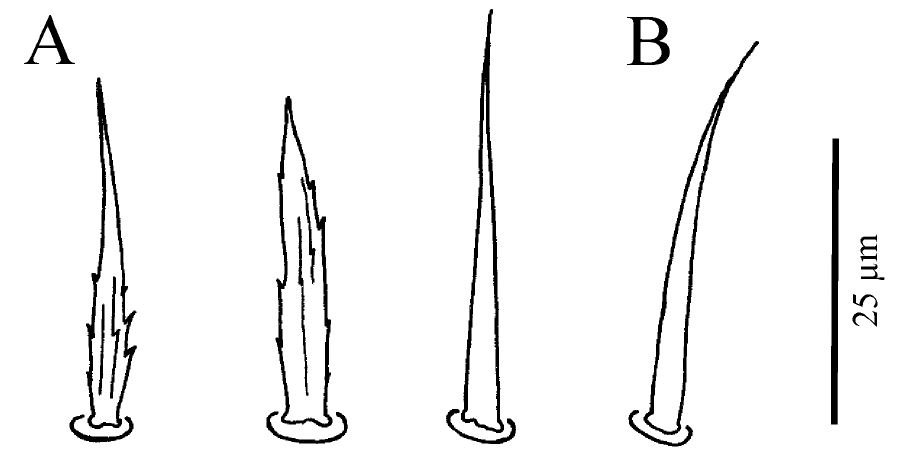
Figure 7. Neocarus spelaion sp. n.: A Details of variation in morphology found in pregenital and genital setae in male B Detail of female genital